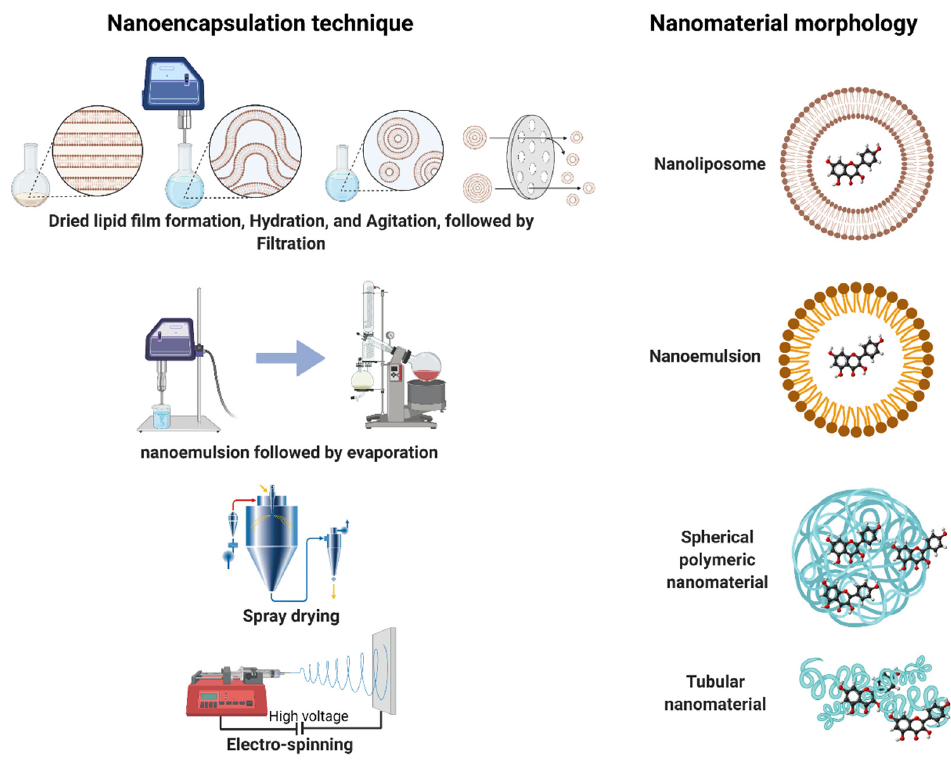
Figure 2. Most used techniques for nanoencapsulation of flavonoids. Table 1. Nanoencapsulation methods applied for